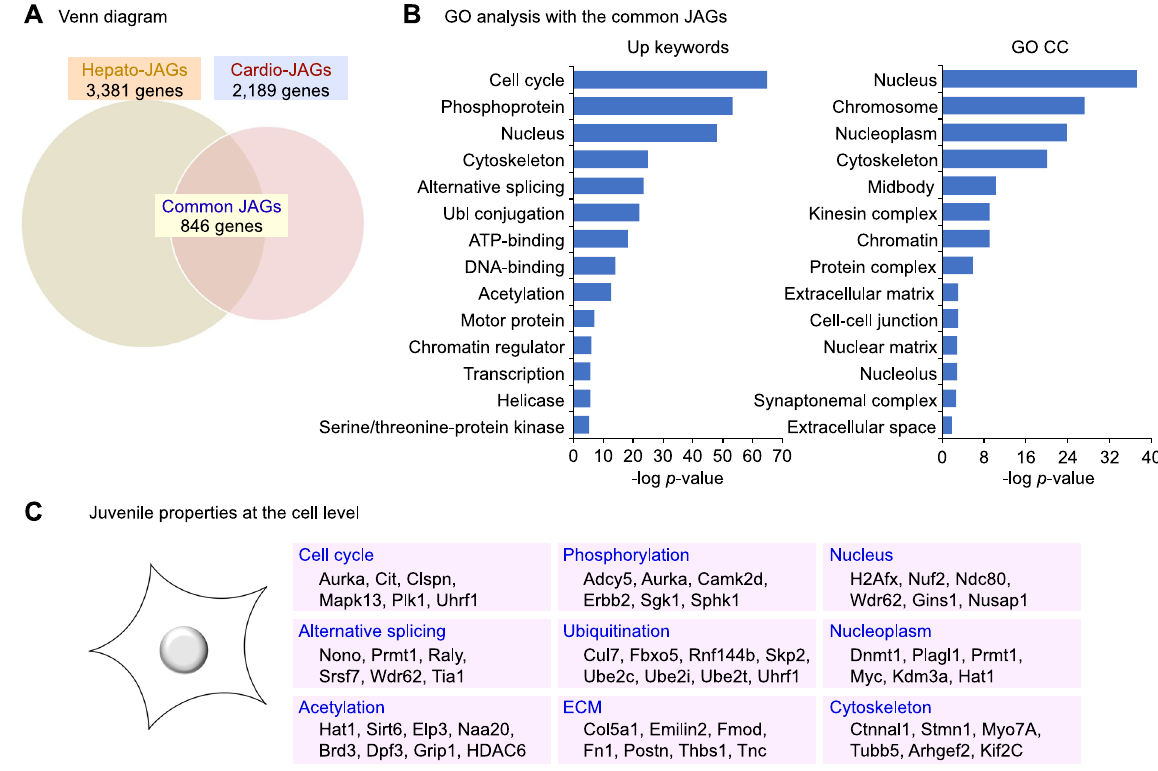
Figure 6. The common JAGs exhibit a distinct gene expression profile. ( A ) The Venn diagram showing the common JAGs as overlapping genes between the hepato-JAGs and the cardio-JAGs. ( B ) The GO analysis with the common JAGs. ( C ) The cellular functions that constitute the juvenile properties at the cell level.